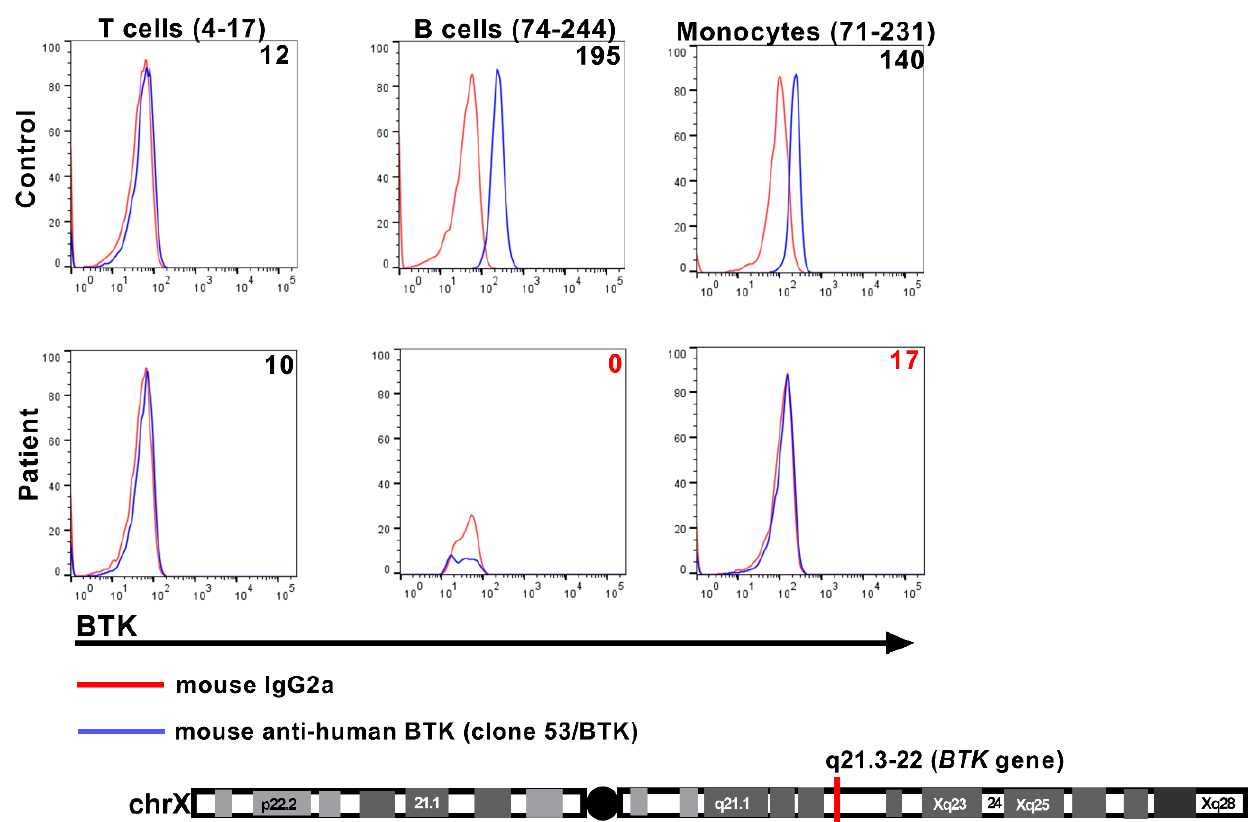
Figure 1. Assessment of cytosolic BTK expression by flow cytometry. The histogram overlay plots display the presence and/or absence of BTK protein expression (blue histograms) in the cytosol of the indicated cellular subsets. The numbers listed in parentheses adjacent to the cell subset label reflect the clinically validated reference ranges (5–95th percentiles) for that particular cell subset, derived from the background-subtracted median fluorescence intensity (MFI) of BTK expression evaluated for 34 healthy control donors. The numbers listed within each histogram overlay plot reflect the background-subtracted MFI of BTK expression for that specific cell subset for each donor. The specificity of the BTK signal was determined by also separately staining the cells with a dose-matched, isotype control Ab (red histograms). T cells lack BTK expression and serve as an internal specificity control in the assay.